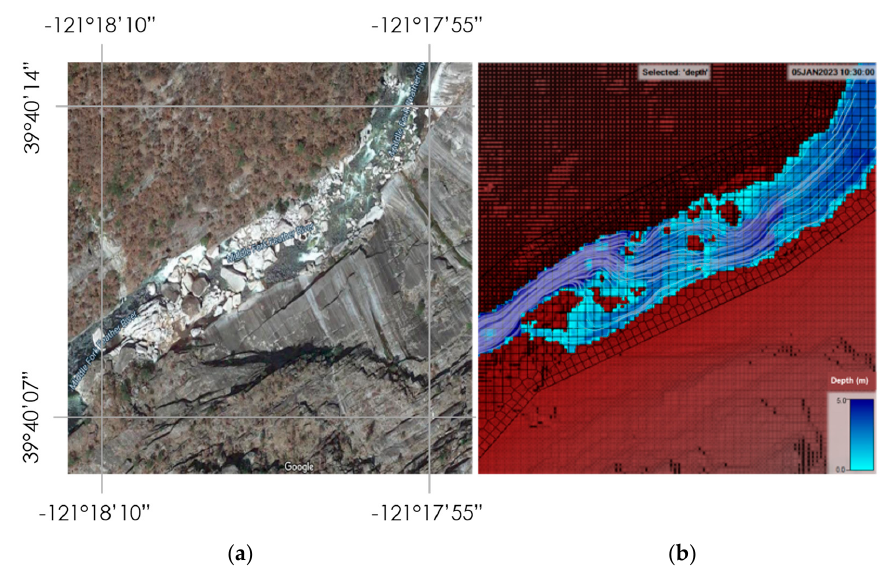
Figure 7. ( a ) Image of a section of the MF Feather River, ( b ) an example of the flood depth overlaid with the velocity streamline from the 2D HEC-RAS model at a rocky section of the MF Feather River for the 5-year event.